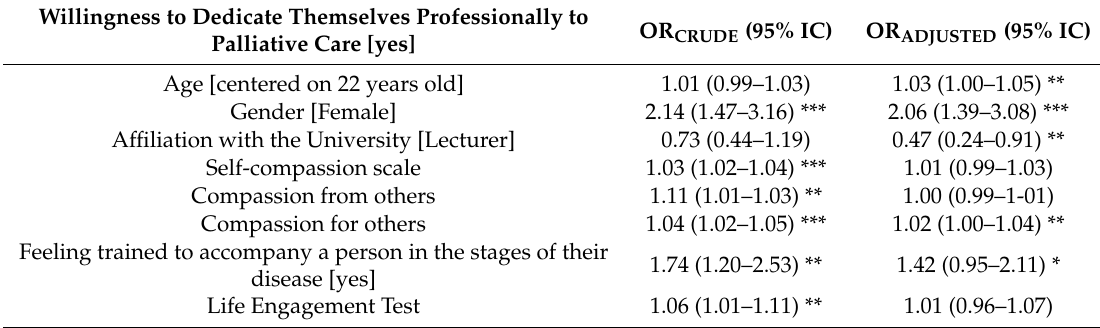
Table 8. Willingness to dedicate themselves professionally to Palliative Care among students and lecturers (n = 536). Univariate and multivariate regression models.